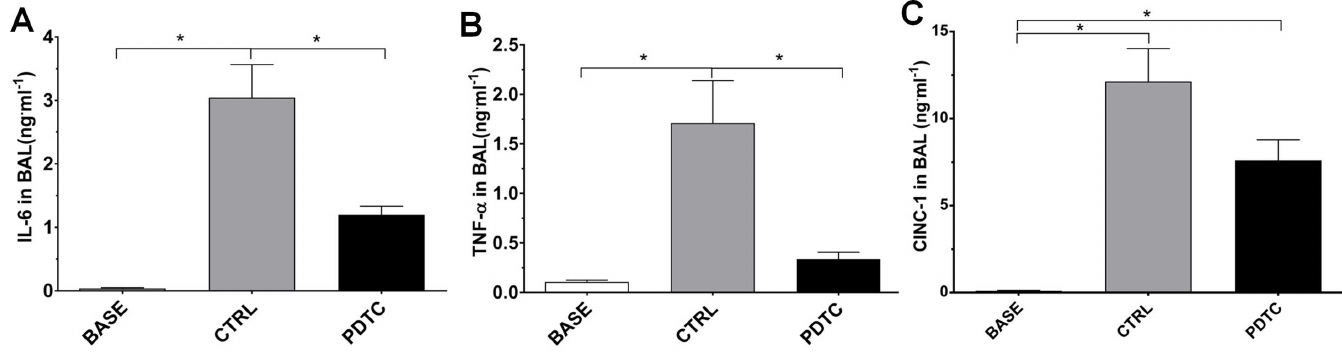
Fig 3. Concentrations of inflammatory cytokines in the BAL fluid. BAL fluid concentration of IL-6 (A), TNF α (B) and CINC-1 (C), expressedin ng . ml -1 BAL fluid. BASE group: BAL fluid was obtained from normal rats sacrificedwithout any intervention (normal values, N = 3); CTRL: Ischemia followedby EVLP with Steen ® solutionalone (N = 6); PDTC: Ischemia followedby EVLP with PDTC treatment (N = 6). Means ± s.e.m. * p < 0.05.(ANOVA followedby Tukey’s test).